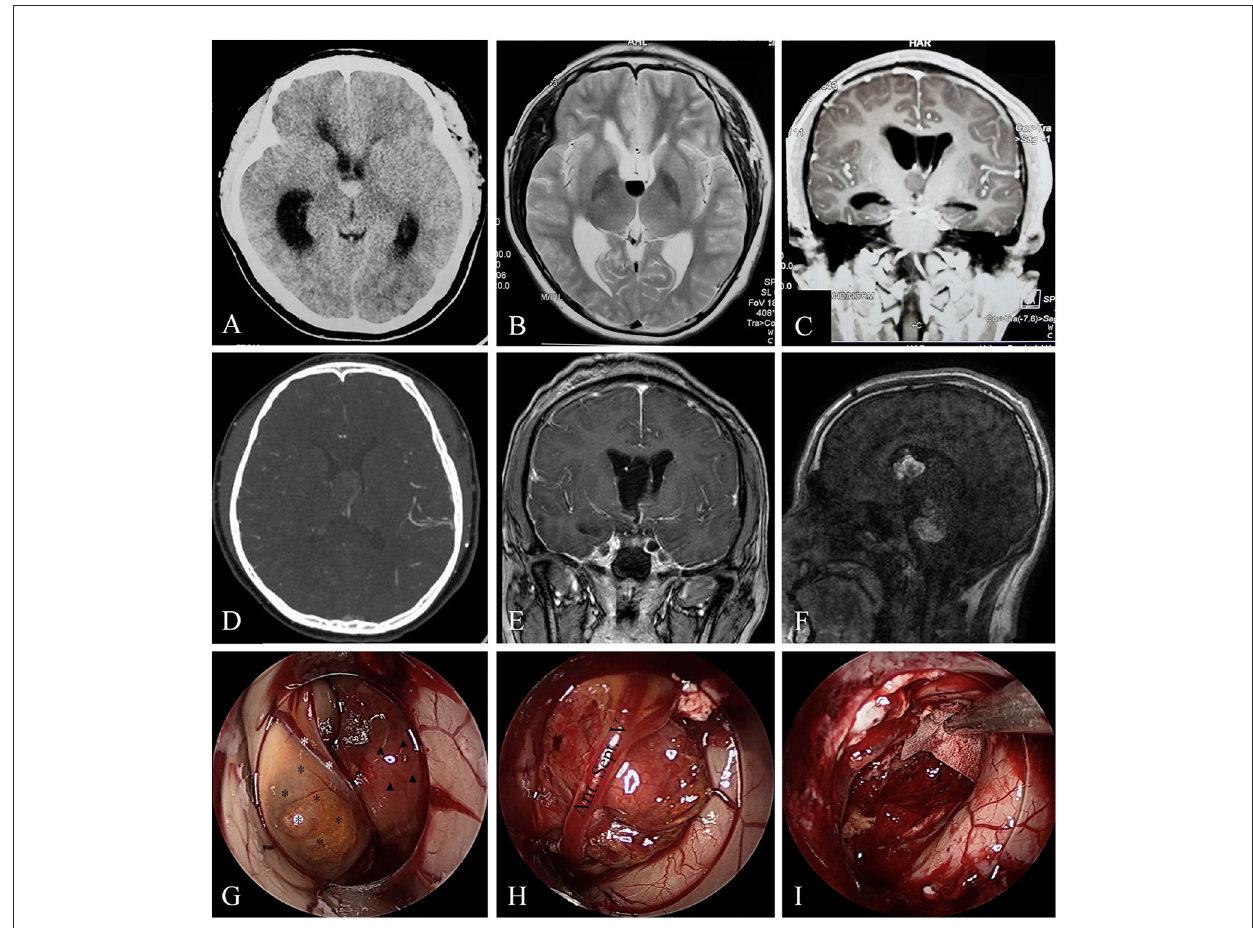
FIGURE2 A rare case of CH originating from septum pellucidum with multiple recurrences. Case 9, the brain CT (A) of a 16-year-old boy revealed a hemorrhagic lesion of the third ventricle. T2-weighted image (B) showed fluid level in the lesion, suggesting hemorrhage. Coronal enhanced MRI (C) depicted a non-enhanced lesions causing obstructive hydrocephalus. Brain CTA (D) in our hospital revealed the lesion was without apparent blood supply. Endoscopic surgical resection was achieved in our hospital, and postoperative enhanced MRI showed gross total resection of the lesion (E) . Gd-enhanced MRI (F) showed the two lesions were heterogeneously enhanced. Intraoperative images (G–I) revealed the lesion (black asterisks) originated from the septum pellucidum, compressing the anterior septum vein (white asterisks). A capsuled hematoma (triangles) could also be observed in the third ventricle (G) . We carefully separated and protected the anterior septum vein (H) during the operation. At last, the lesion and hematoma were removed (I) .